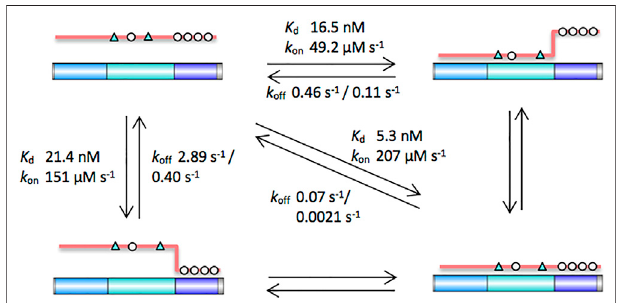
FIGURE 7 | Schematic of the contributions of the different subdomains of APC to the interaction with β -catenin. The key contacting residues are denoted in triangles (lysine-binding residues) and circles (phosphomimetics). Key dissociation constants and rates of association and dissociation are shown. The intrinsic β -catenin-binding af fi nity of the b domain can be estimated from the af fi nity of APC, which has a weakened c domain. The intrinsic β -catenin-binding af fi nity of the c domain can be estimated from the af fi nity of pAPC D1486S, which has a weakened b